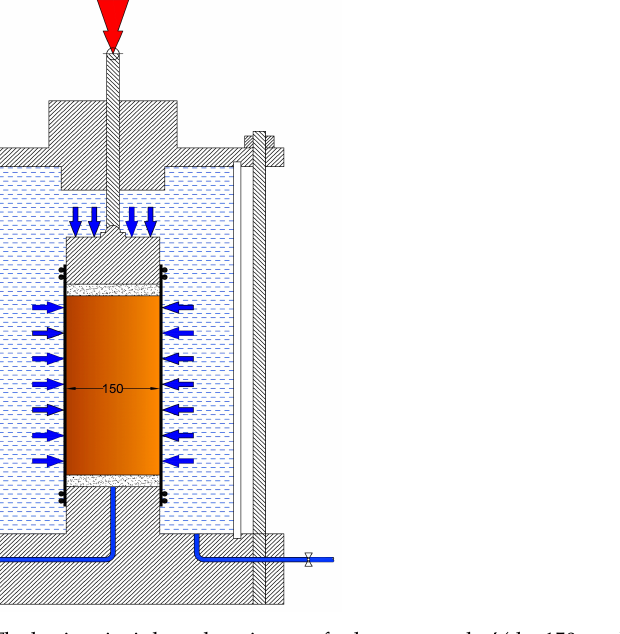
Figure 12. The modification of triaxial test equipment for underwater coal mining cutting re- sistance testing Similarly, cutting resistance tests in underwater coal mining conditions were carried out on prismatic specimens, which height was h = 100 mm, width a = 100 mm, and length b = 100 mm (diagonal of the base specimen was about 141 mm) (Figures 13 and 14), which are placed at the center of the triaxial cell base. During the test, the sample was not iso- lated with rubber membrane, because the material (coal) in natural conditions is also di- rectly exposed to the water pressure at a certain depth. After installation of sample and triaxial cell closure, the cell is filled with water, with the pressure in the water being